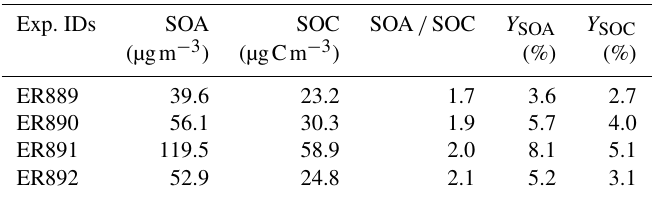
Table 3. Formation and yields of SOA ( Y SOA ) and SOC ( Y SOC ). All organic and carbon aerosol masses are corrected for a wall loss of 0.067h − 1 (Kleindienst et al., 2012). Exp. IDs